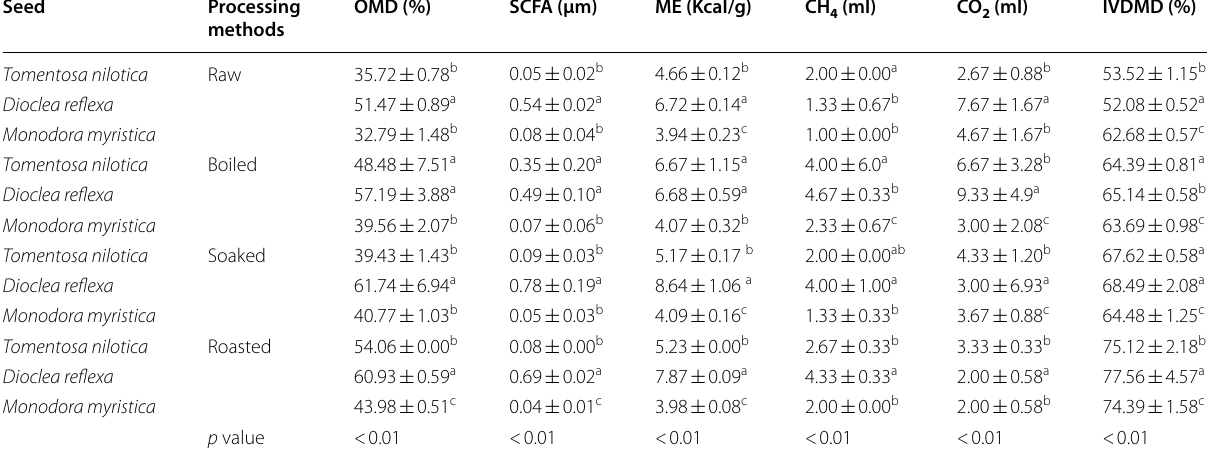
OMD organic matter digestibility, SCFA short-chain fatty acids, ME metabolizable energy, IVDMD in vitro dry matter digestibility a ,b,c Means within the same row with different superscripts are significantly ( p < 0.05) different. n